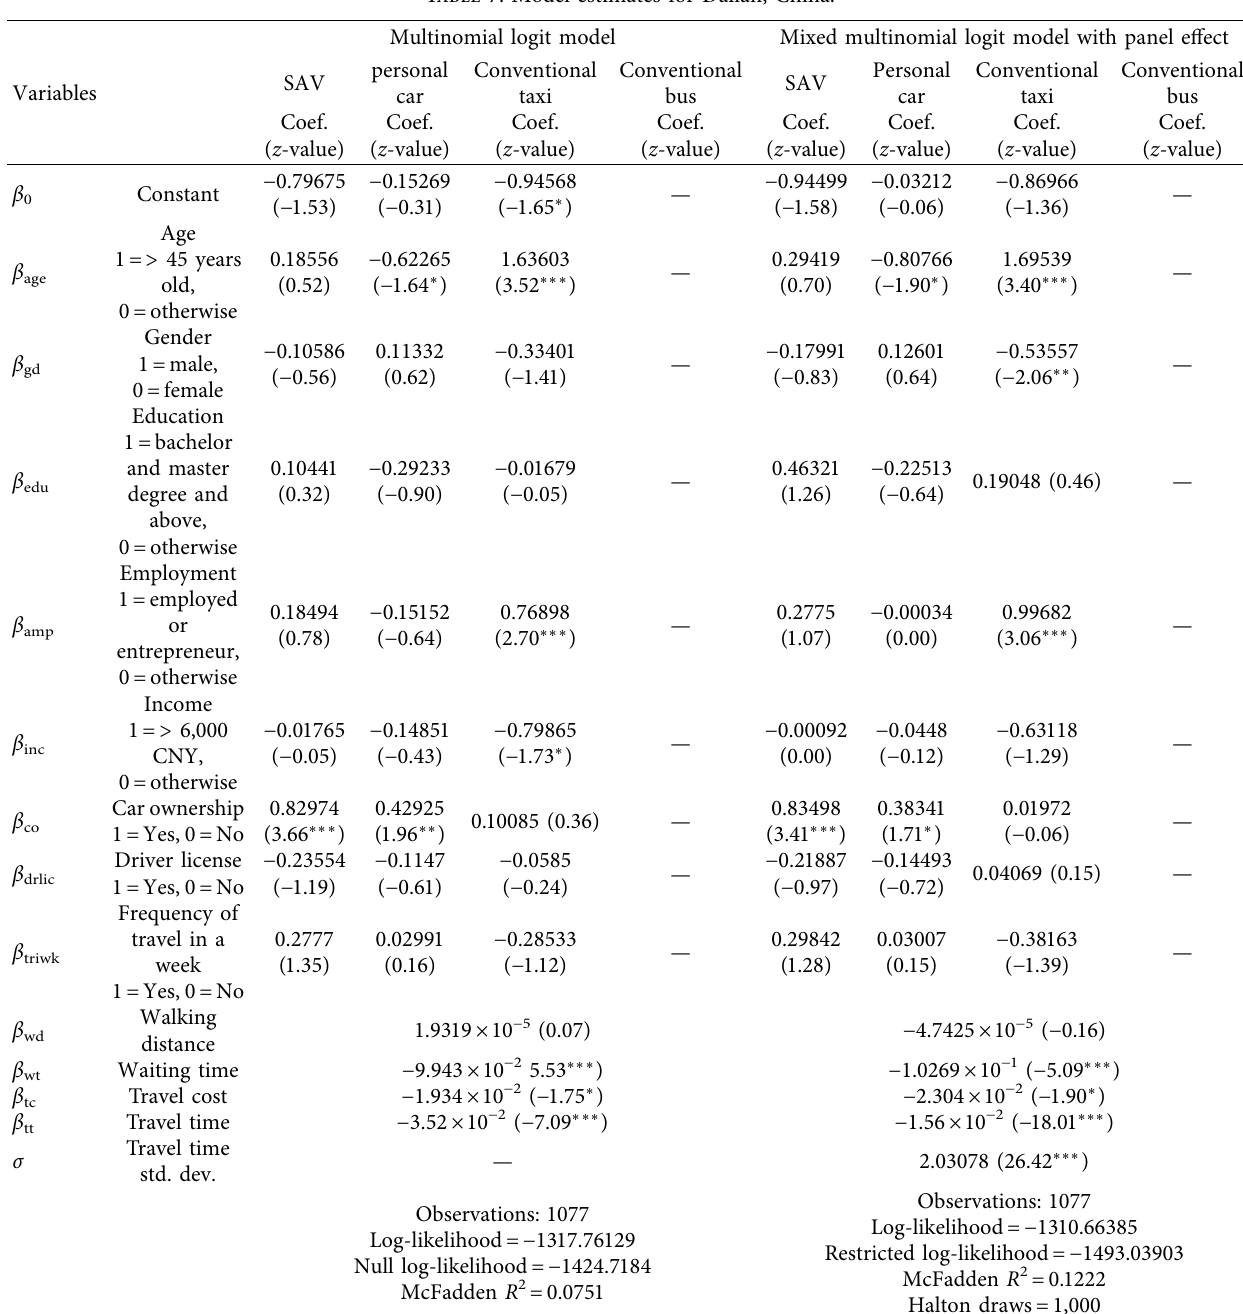
Table 7: Model estimates for Dalian,